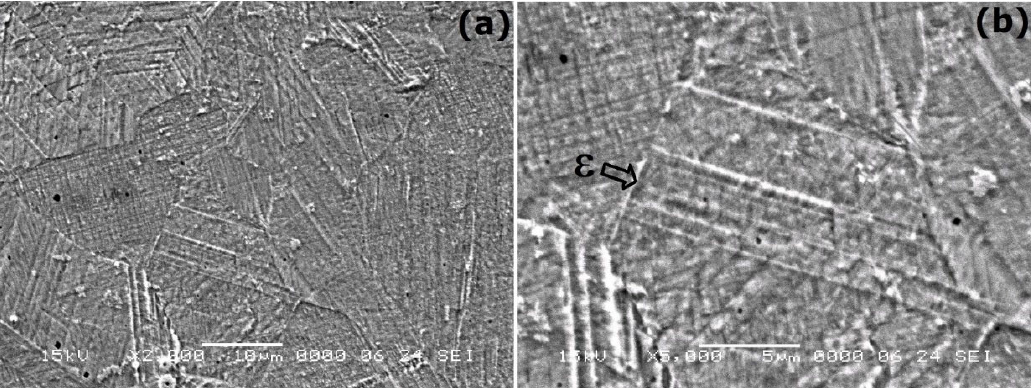
Figure 4. Typical SEM micrographs of a specimen in its initial hot-rolled state after DMA-SS-3PB: ( a ) general aspect; ( b ) detail of ε -hcp stress-induced martensite plates.